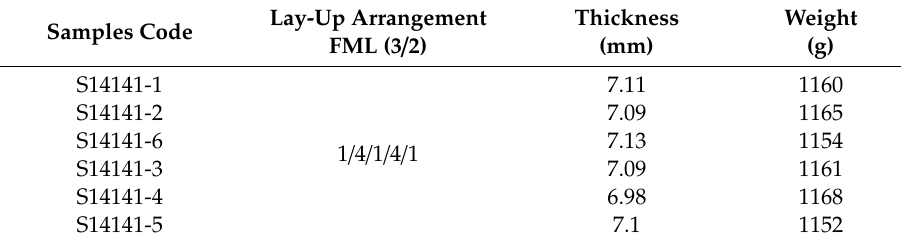
Table 1. Samples lay-up arrangement, thickness, and weight.